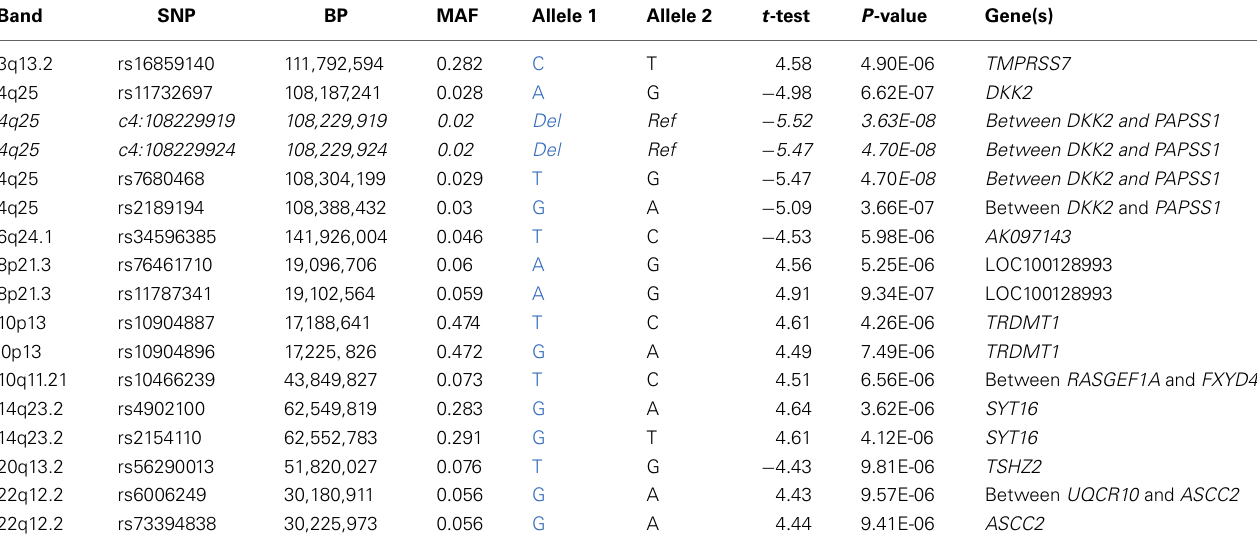
BP based on HG19; imputed SNPs are in italic.